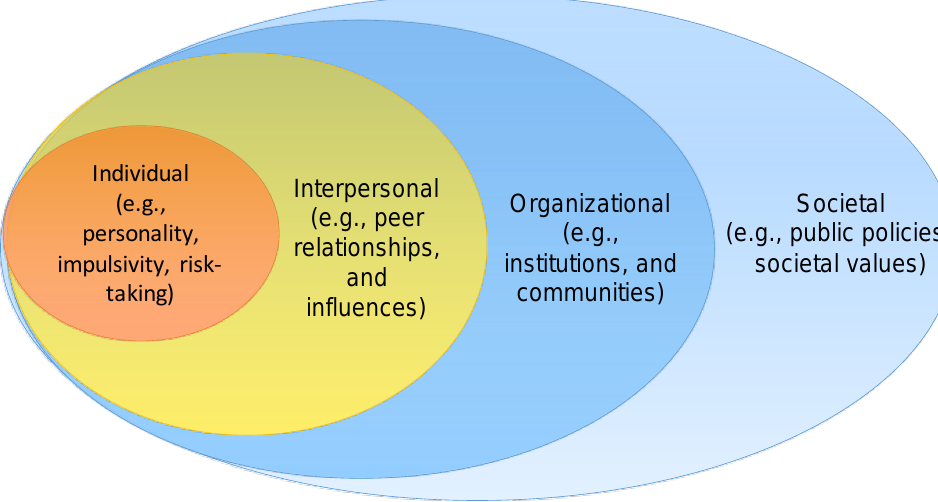
Figure 1. Social ecological model for investigating problem gambling behavior.